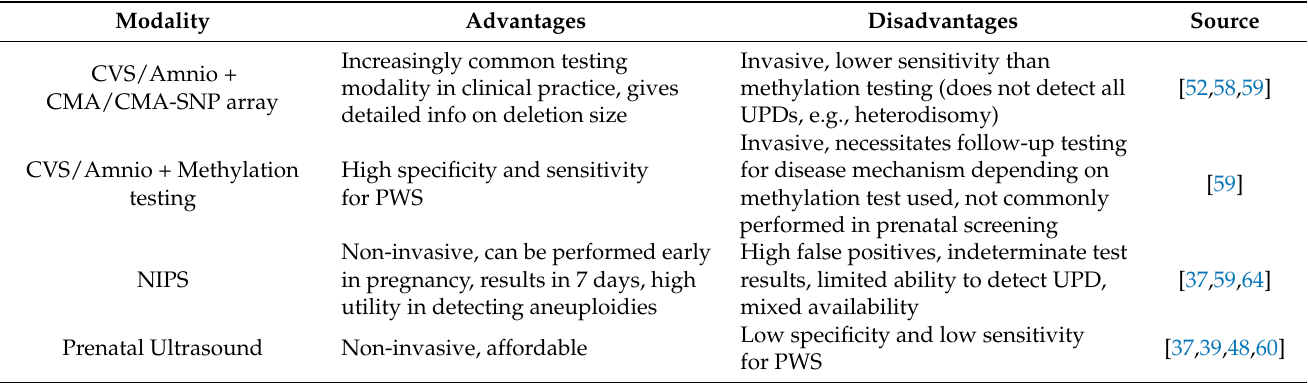
Table 2. Comparison of prenatal diagnostic strategies for